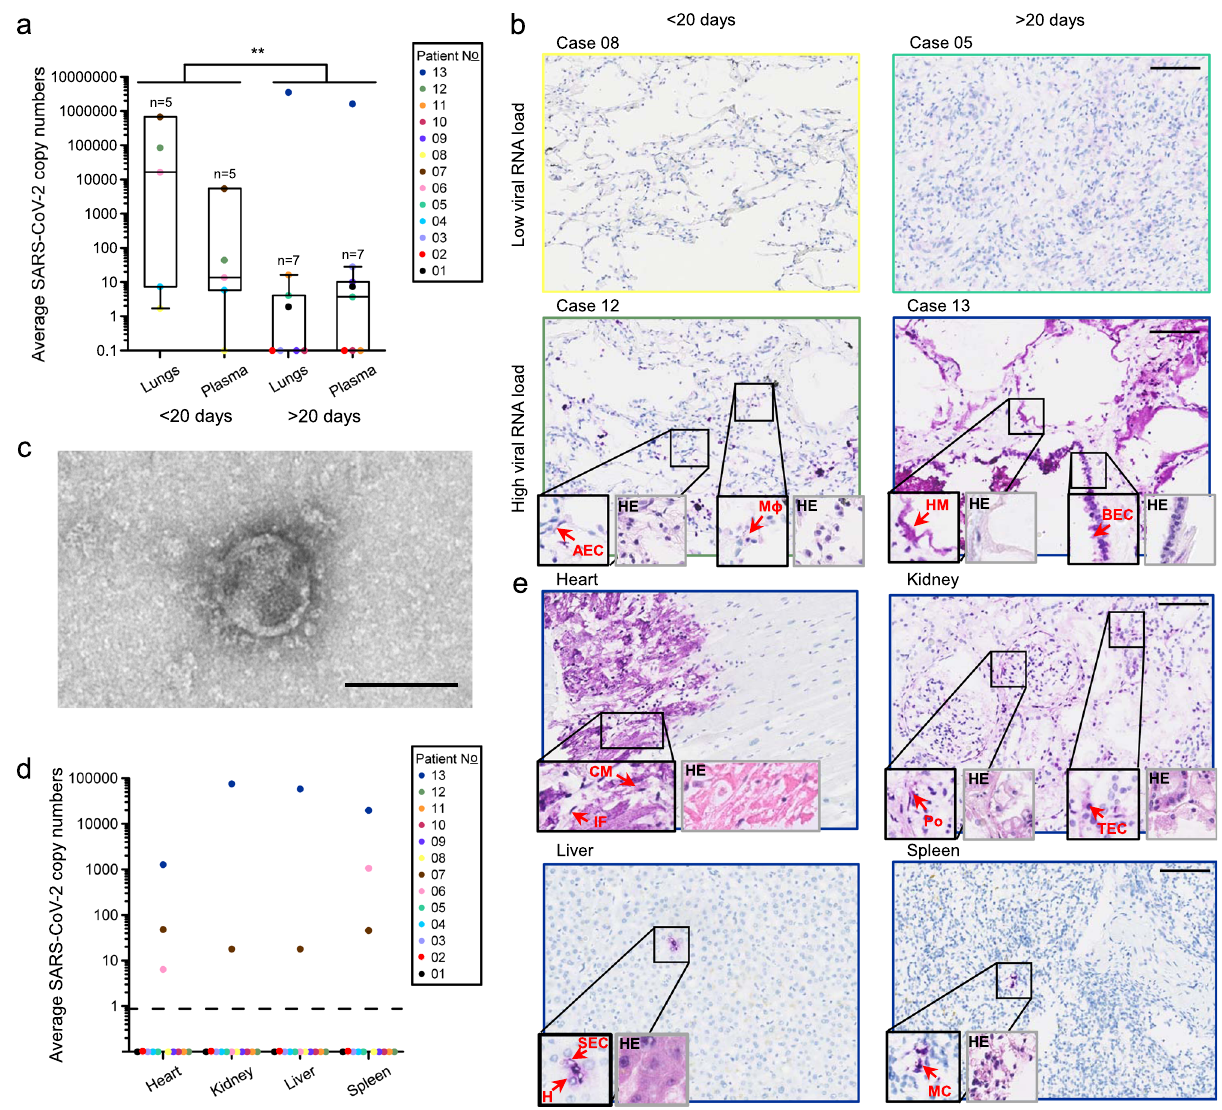
Fig. 1 Detailed virological analysis of 13 postmortem COVID-19 cases. a SARS-CoV-2 RNA loads, as measured with RT-qPCR, on a total of 40 ng RNA in the lungs or 1 mL of plasma of different cases (different colors) with short- or long-lived disease (<20 or >20 days after onset of symptoms, respectively). Central tendencies for SARS-CoV-2 copies are illustrated as a boxplot where the band indicates the median, the box indicates the fi rst and third quartiles, and the whiskers indicate the minimum and maximum of all of the data. The signi fi cance of two-way ANOVA (with categorical variables duration and anatomical compartment) between the mean SARS-CoV-2 copy numbers of long and short duration is indicated on top (** P = 0.002; F = 12.589; df = 23). Source data are provided as a Source Data fi le. b SARS-CoV-2 nucleocapsid (NP) staining (in purple; large images and 2X-enlarged smaller images delineated in black) and corresponding hematoxylin-eosin (HE) staining (2X-enlarged smaller images delineated in gray) of paraf fi n-embedded sections of lung tissue of four different cases with low (<5 copies/40 ng RNA) or high (>5 copies/40 ng RNA) viral RNA loads and short- or long-lived disease. Arrows show speci fi c SARS-CoV-2 NP-positive cells or hyaline membranes (HM). Picture linings correspond to the respective case colors shown in the legend of Fig. 1a. Lower magni fi cation IHC and HE images are shown in Fig. S3. All scale bars represent 100 µ m. AEC alveolar epithelial cell, BEC bronchiolar epithelial cell, HM hyaline membrane, M ɸ macrophage. c Transmission electron microscopic image of a SARS-CoV-2 particle from plasma-derived viral progeny on Vero E6 cells. Controls are shown in Fig. S4c. Scale bar indicates 100 nm. d SARS-CoV-2 RNA loads on a total of 40 ng RNA, as measured with RT-qPCR, in selected extrapulmonary organs. Source data are provided as a Source Data fi le. e SARS-CoV-2 NP staining (in purple; large images and 2X- enlarged smaller images delineated in black) and corresponding hematoxylin-eosin (HE) staining (2X-enlarged smaller images delineated in gray) of paraf fi n-embedded sections of extrapulmonary tissues of the case 13. Arrowheads indicate SARS-CoV-2 NP-positive cells. Picture delineations correspond to the respective case colors shown in the legend of Fig. 1d. Lower magni fi cation IHC and HE images are shown in Fig. S5. CM cardiomyocyte, IF interstitial fi broblast, SEC sinusoidal endothelial cell, H hepatocyte, MC myeloid cell, Po podocyte, TEC tubular epithelial cell. Scale bars represent 100 µ respectively) across all organs examined (Fig. S6), con fi rming the in vivo relevance of ACE2 and TMPRSS2 in SARS-CoV-2 cell infection.